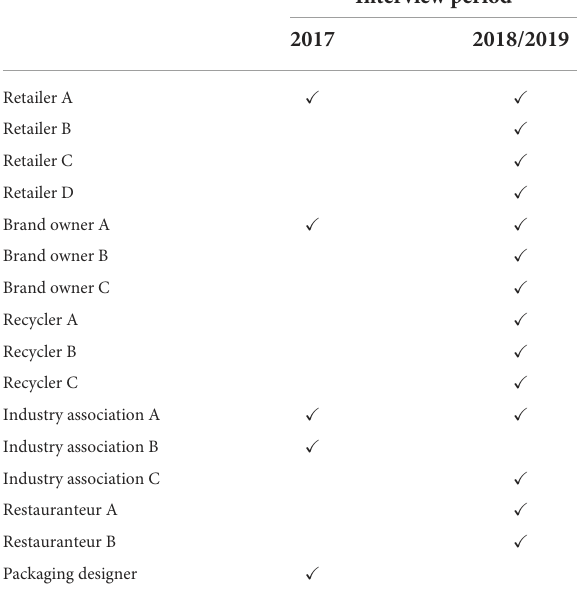
TABLE 3 Consulted value chain actors and the corresponding interview